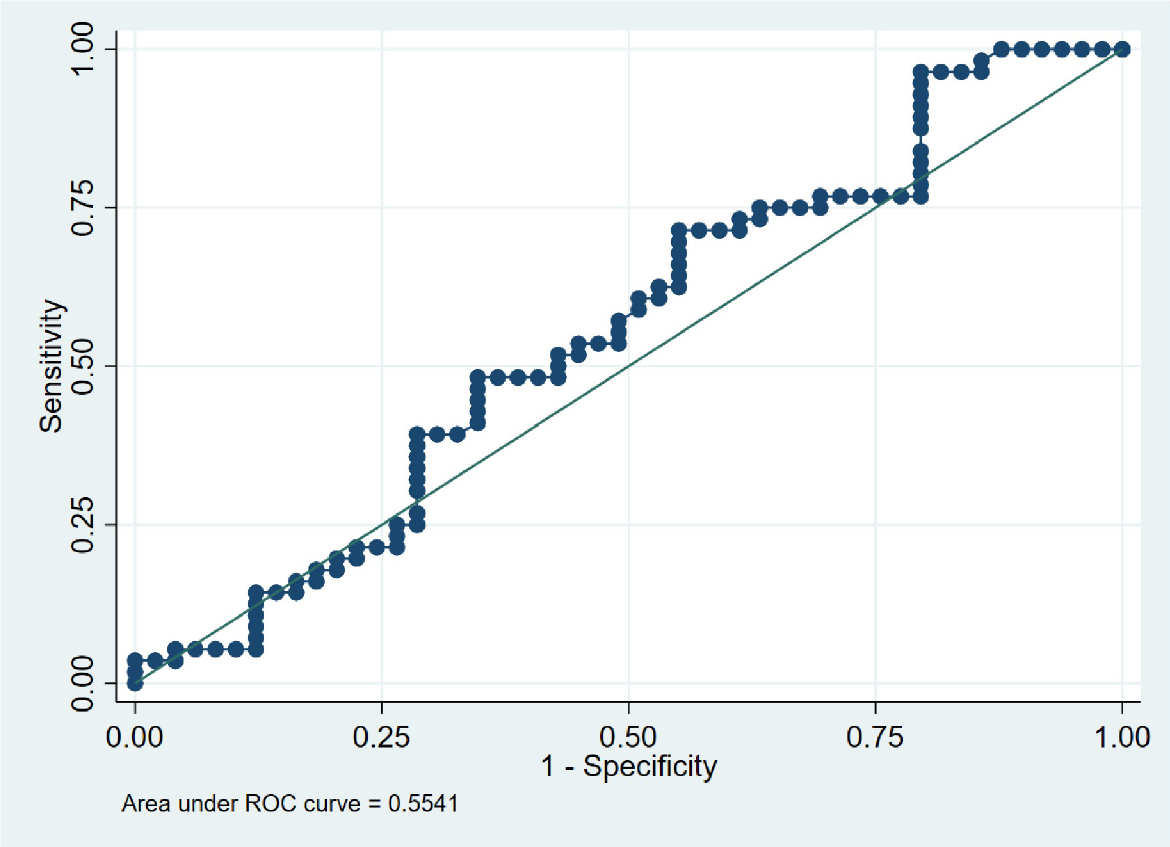
Fig 4. ROC curve showing an accuracy of LL-37 levels in differentiating between active TB disease and LTBI with a sensitivity of 71.4% and specificity of 44.9%.